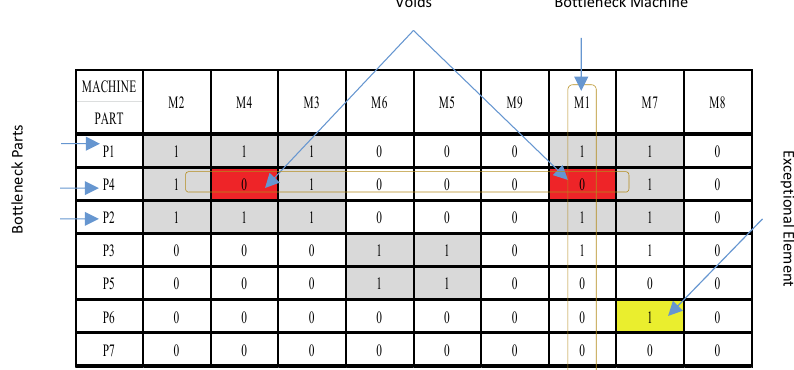
Fig. 4. Graphical view of voids, exceptional elements, bottleneck machines and bottleneck